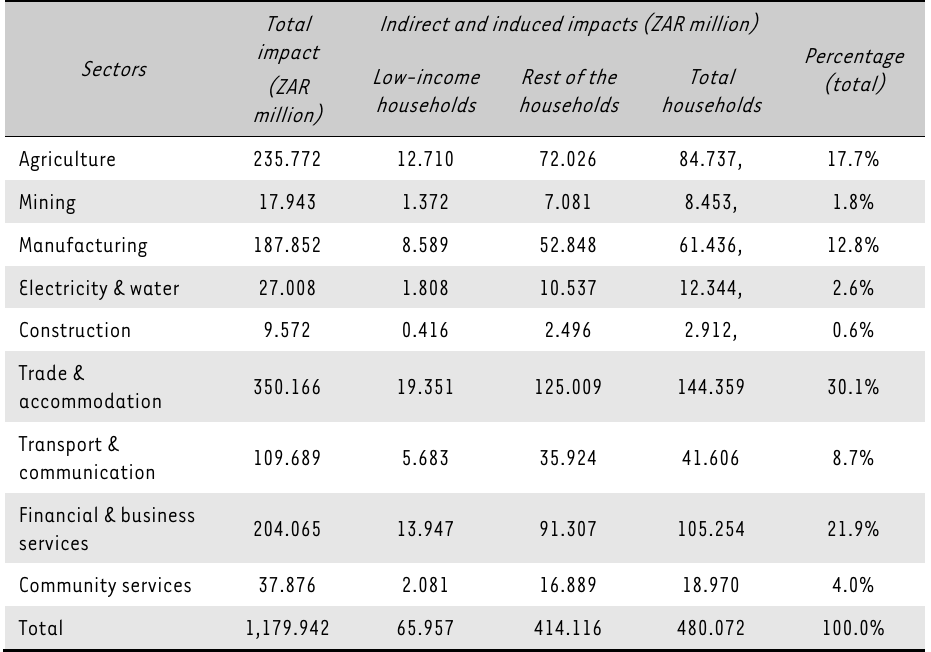
Percentage (total) Low-income